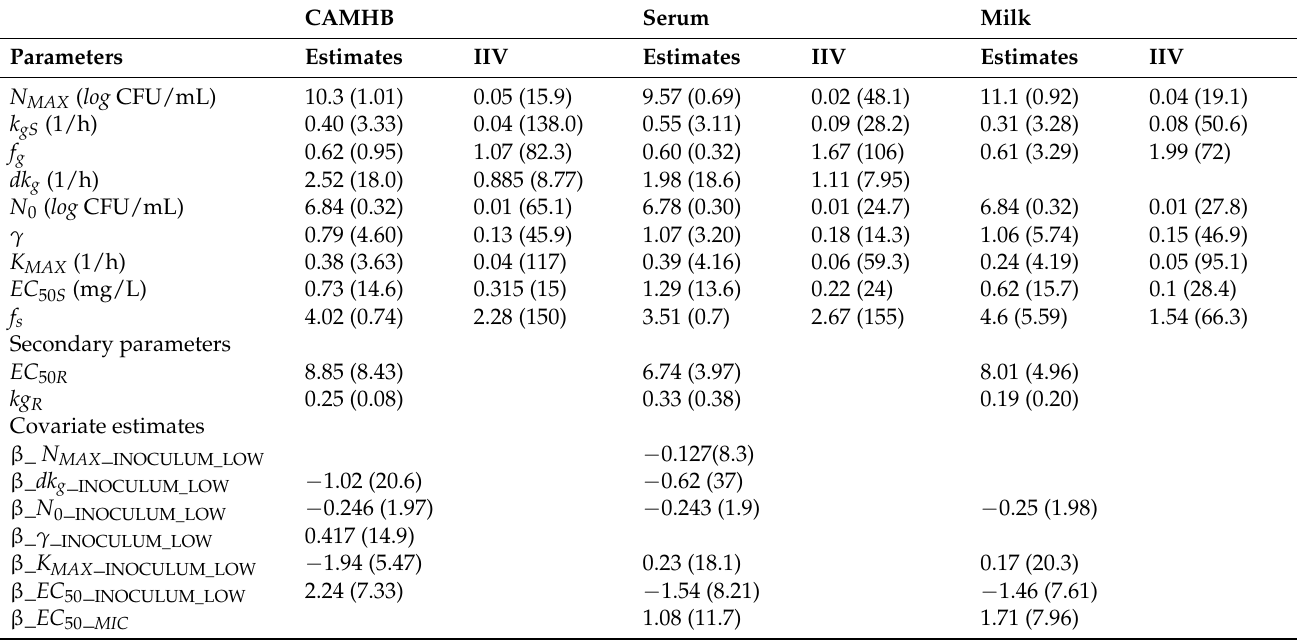
Table 3. Final parameters from two population bacterial model for each growth medium used. Data presented as estimates with % RSE, including inter-individual variability